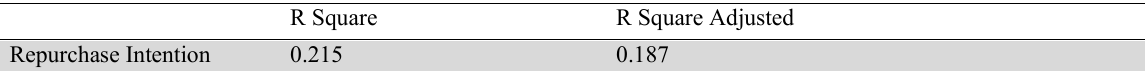
R Square Value R Square R Square Adjusted Repurchase Intention 0.215